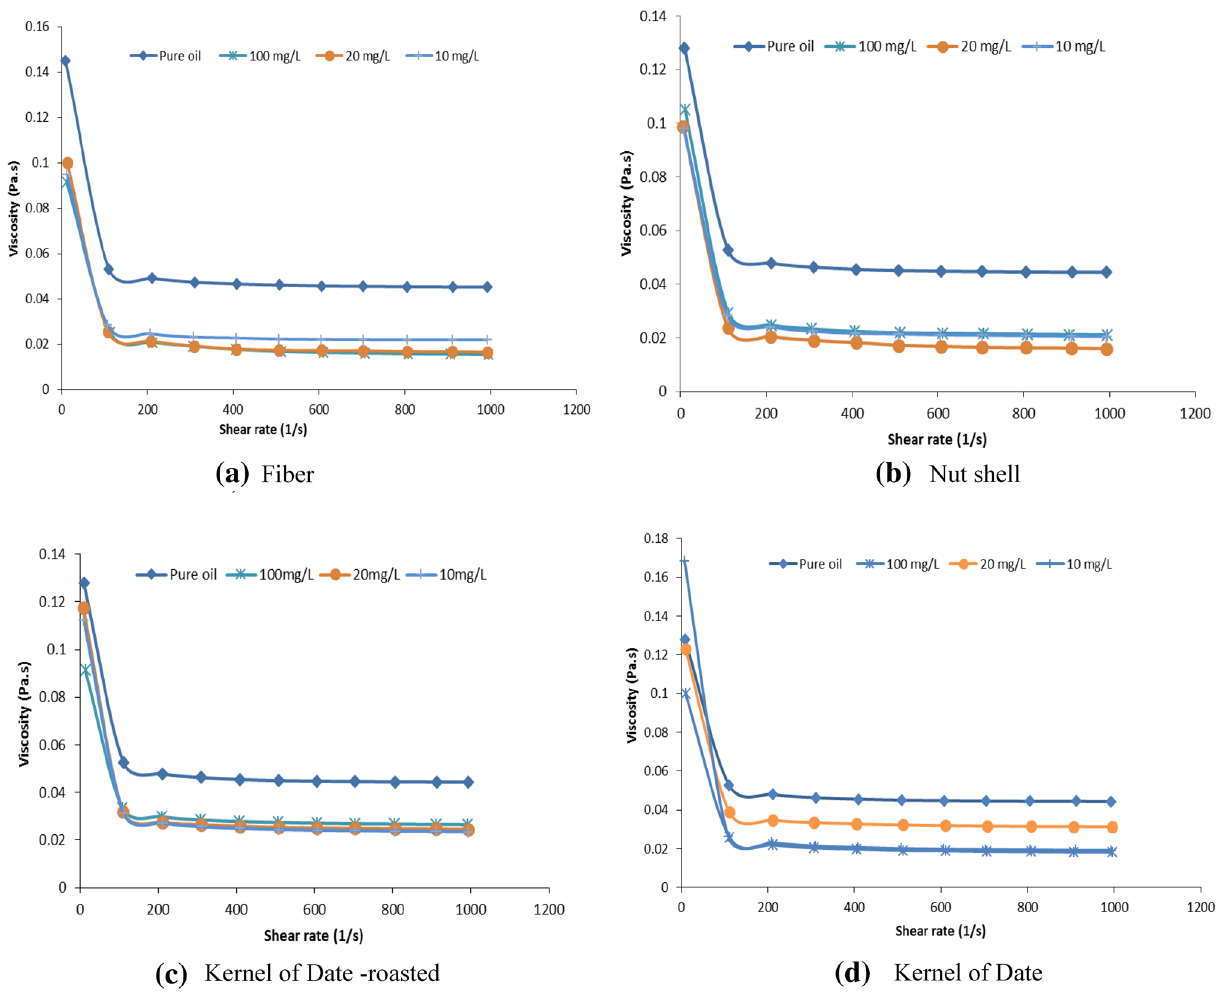
Fig. 4 Viscosity of light crude oil using bio materials (150